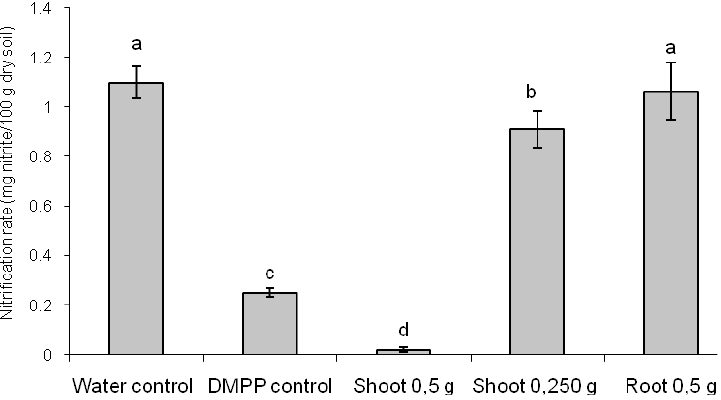
Fig. 3. Mean value of nitrite produced by application of 0.250 or 0.500 g shoot homogenate and 0.500 g root homogenates from B. humidi- cola during 50 hour incubation period. DMPP was used with a concentration of 10 times of normal concentration (1% of N-NH of means was done at 5% of Duncan test. Data are averages of four replicates ±